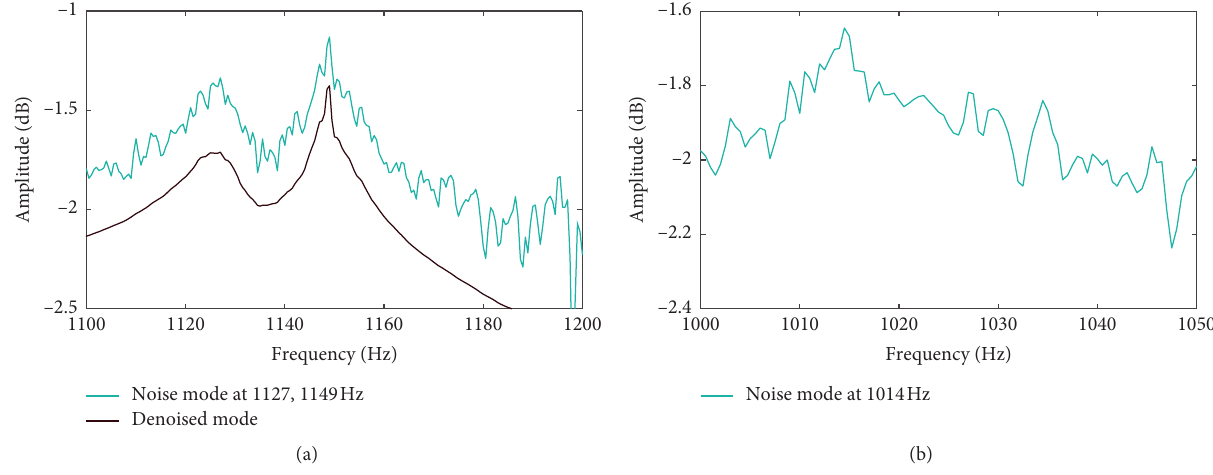
Figure 15: (a) Noise modes at 1127 and 1149Hz. (b) Noise mode at 1014Hz.